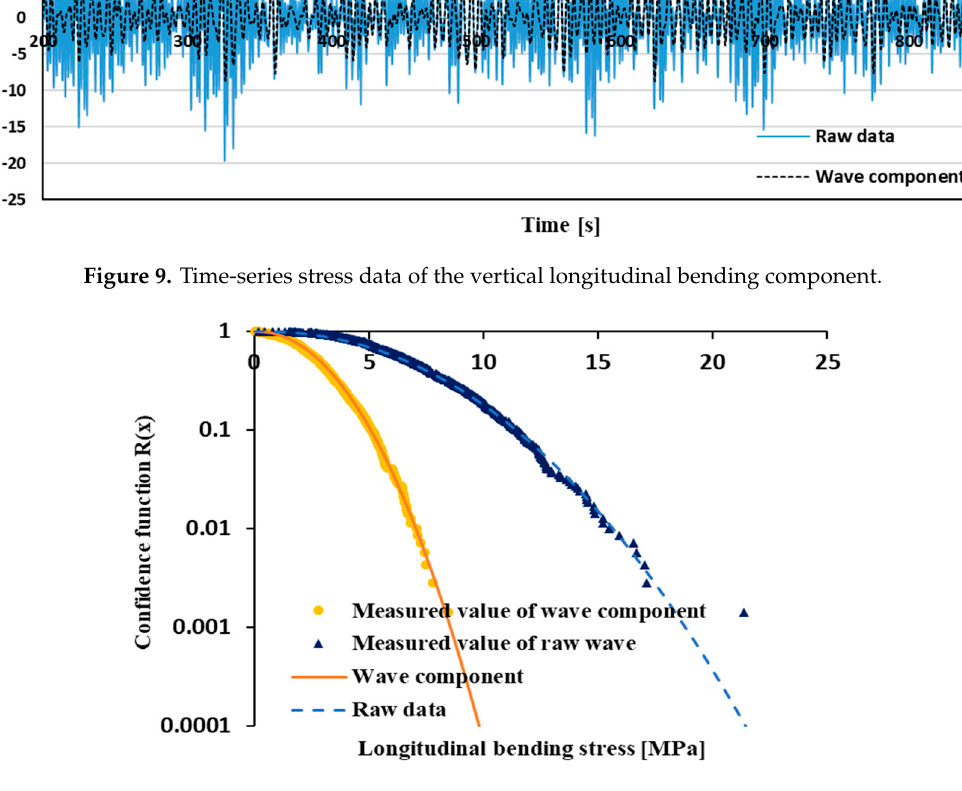
Figure 10. Weibull distribution plot of the peak values of raw data and wave response component of one-hourly data.